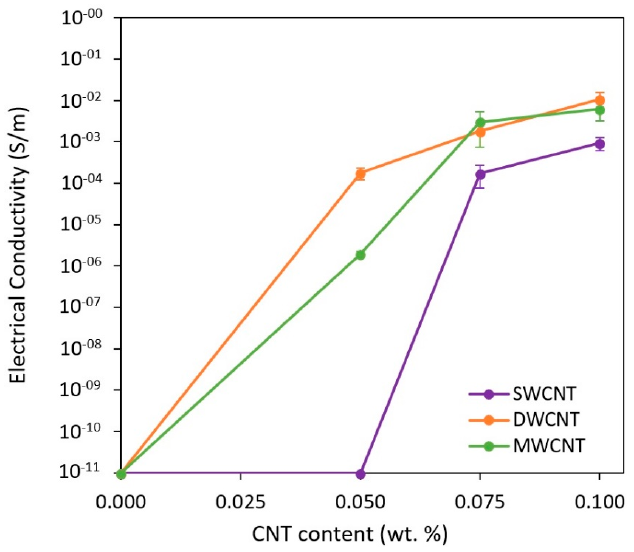
Figure 2. Electrical conductivity as a function of the type and content of